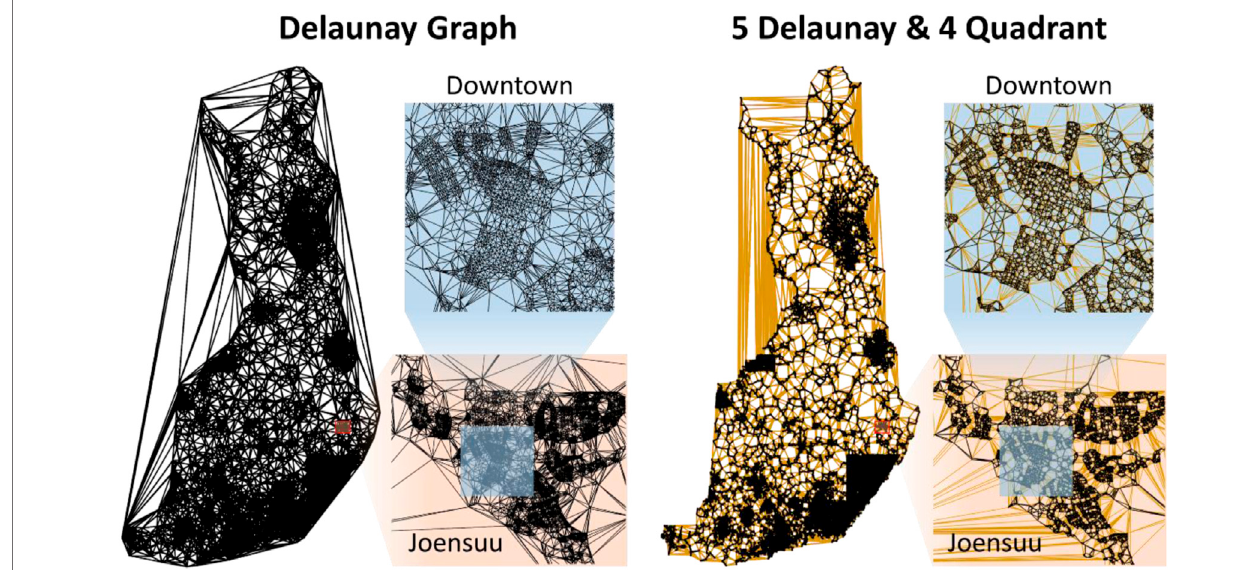
FIGURE 7 | Comparison of Delaunay links and those used in the LKH